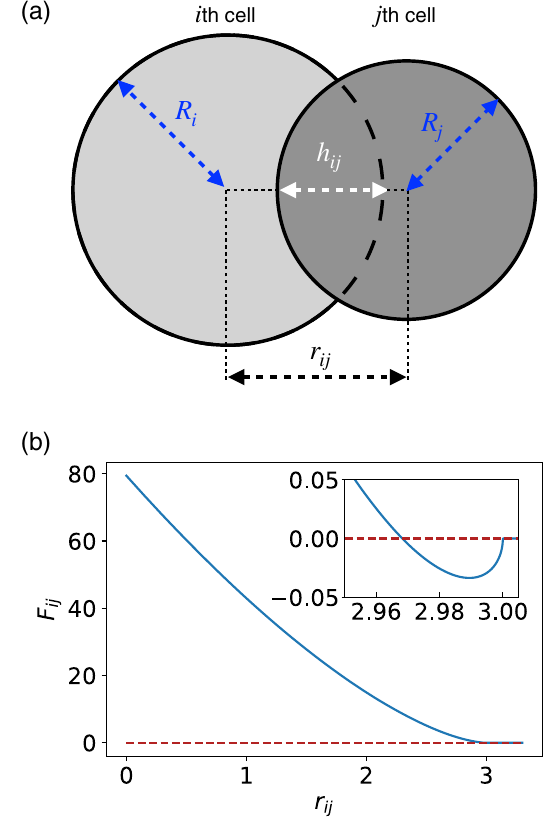
and R . i j ¼ j R − R j , ij i j with ij þ R ¼ 3 > R ij i j